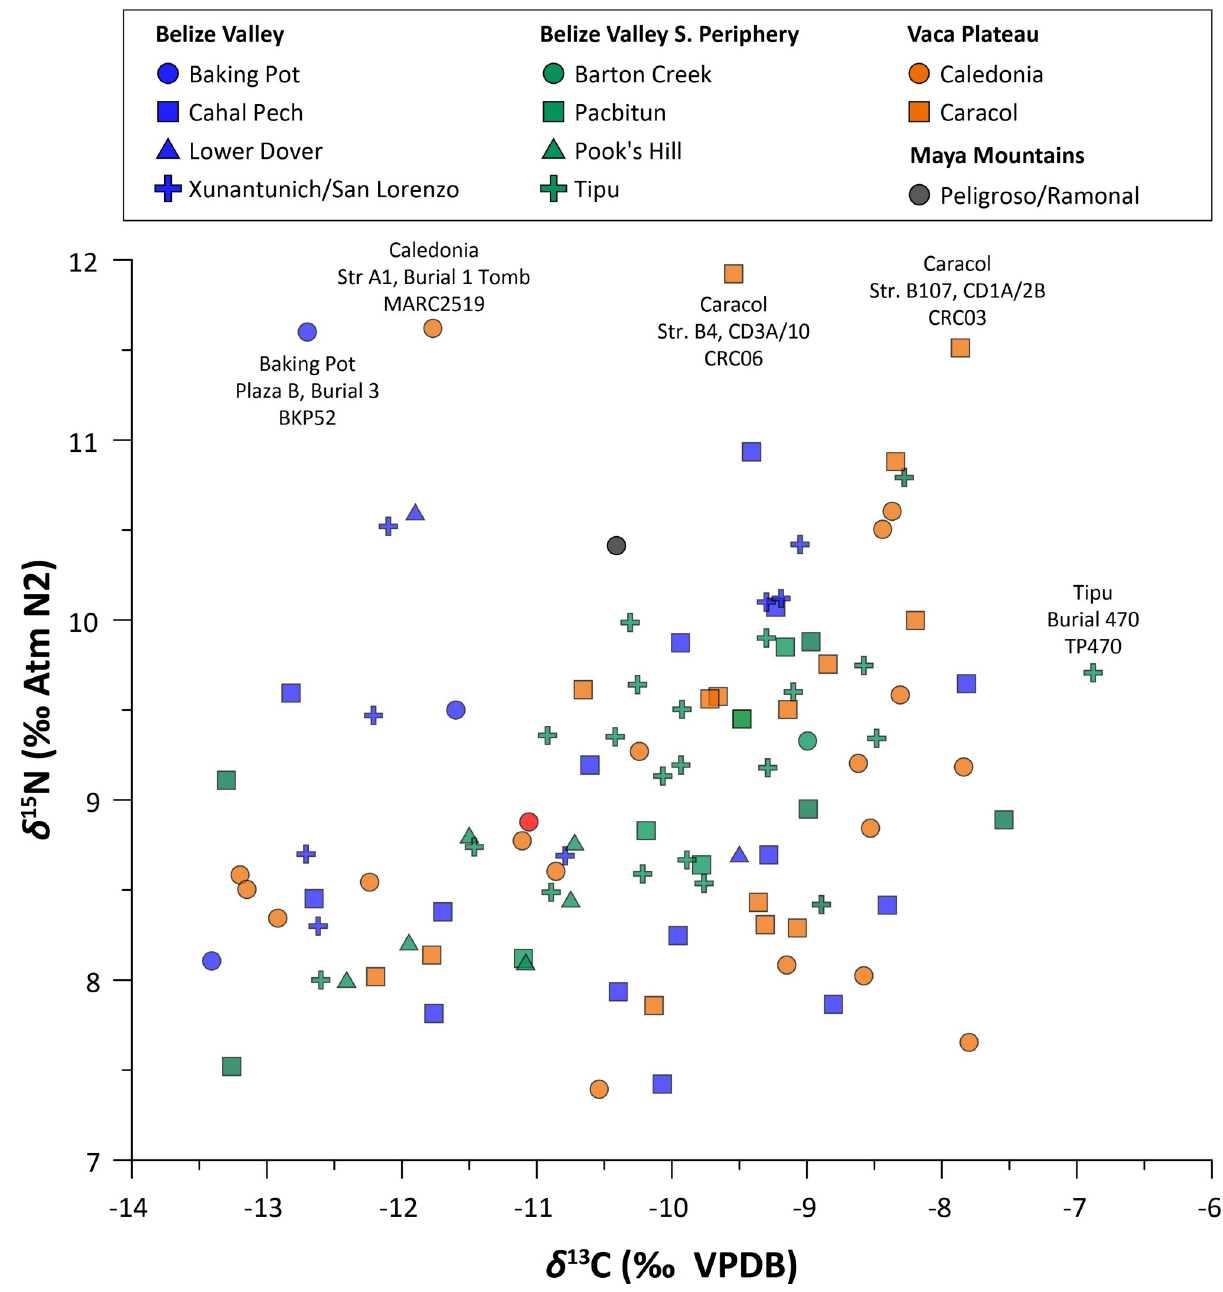
Fig 3. Eastern lowland human δ 13 C and δ 15 N values, with outliers described in text indicated. 17, 19]. To examine variation between geographic zones, we divided sites by their location in the Eastern lowlands in the upper Belize Valley ( n = 28), the Belize Valley Southern Periphery ( n = 38), or the Vaca Plateau zones ( n = 33; following Table 2). No statistically significant dif- ferences were identified between the δ 13 C values (ANOVA, F = 2.24, df = 2, p = .112) and δ 15 N values (ANOVA, F = .42, df = 2, p = .652) by location. Though we could not include the Maya Mountains in these calculations, because of the small sample size of burials ( n = 2), a lack of